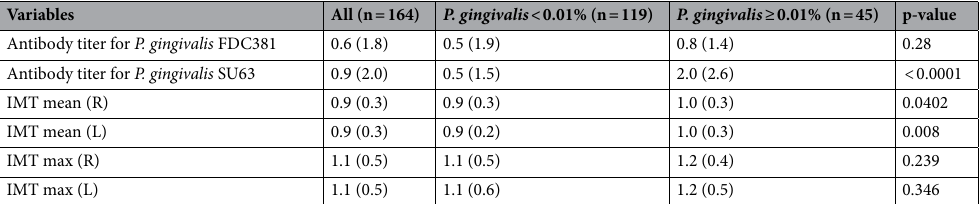
Table 1. Baseline characteristics of the trial population. ALP alkaline phosphatase, ALT alanine aminotransferase, AST aspartate aminotransferase, BMI body mass index, BOP bleeding on probing, CAL